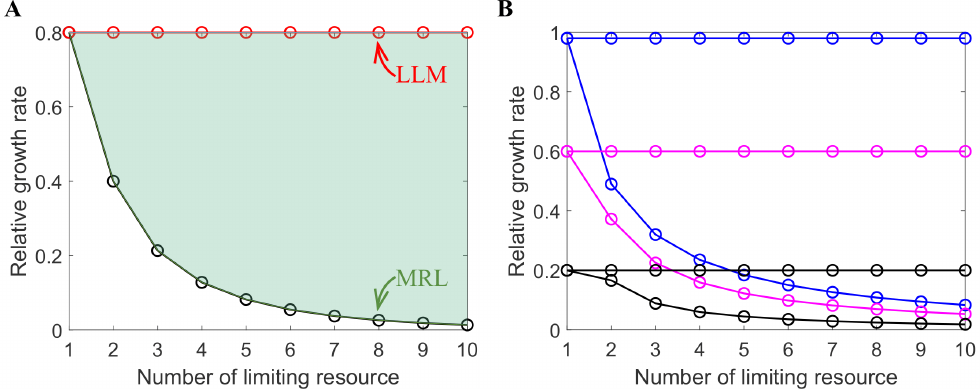
Figure 3. Comparison of Liebig’s growth law and the MRL growth based on the Droop cell quota model. ( A ) Red dots are Liebig’s growth, and green dots are MRL growth. Increasing the number of limiting resources decreases the growth rate in the MRL growth, but has no effect on the growth rate under Liebig’s growth. The green shaded region should contain the true growth. In this case, all resources were assumed to have the same limiting effect. ( B ) Effect of one resource being the most dominant limitation. Blue, magenta, and black represent the scenarios where one resource is slightly, moderately, and significantly more limited than all other resources, respectively. As a resource becomes more limiting, the distance between the two growth formulations decreases. However, this effect quickly saturates as more than three resources are considered. In this case, except for the most limiting resource, all other resources were assumed to be equally